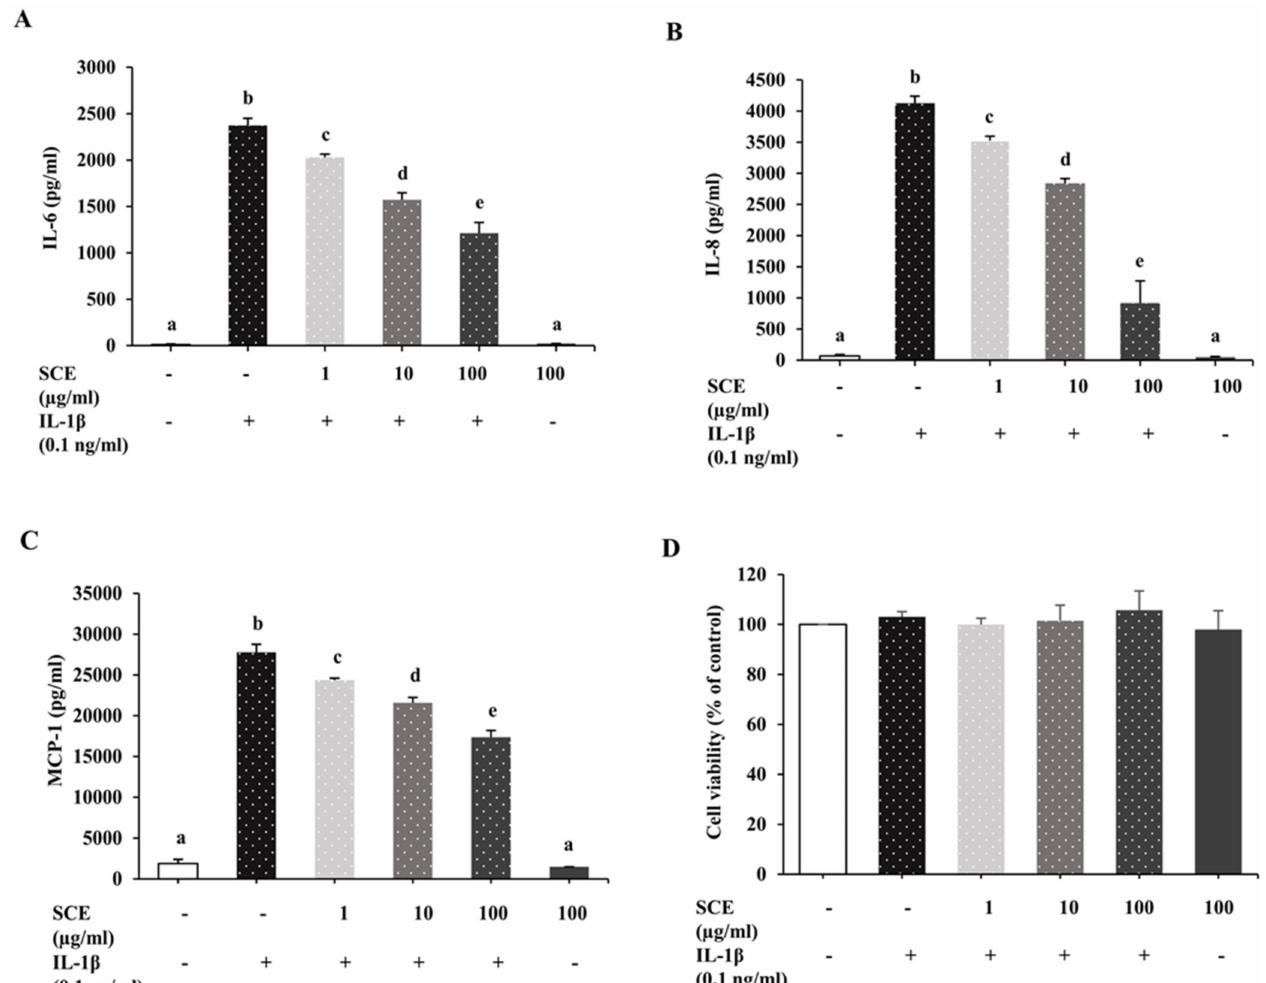
Figure 4. Effect of SCE on IL-6, IL-8, and MCP-1 secretion in ARPE-19 cells induced with IL-1 β . ARPE-19 cells were treated with SCE at 1, 10, and 100 µ g/mL in 0.5 mL of serum-free medium for 1 h before the addition of 0.1 ng/mL IL-1 β for 24 h. A concentration of 0.5% DMSO in serum-free medium was used as the control group. (-) cells were not treated with SCE or IL-1 β , (+) cells were treated with IL-1 β . The concentrations of ( A ) IL-6, ( B ) IL-8, and ( C ) MCP-1 in culture media were measured using ELISA. ( D ) The viability of cells was assessed using an MTT assay. Data are presented as mean ± SD ( n = 3). The different superscripts (a–e) indicate significant differences among groups at p <